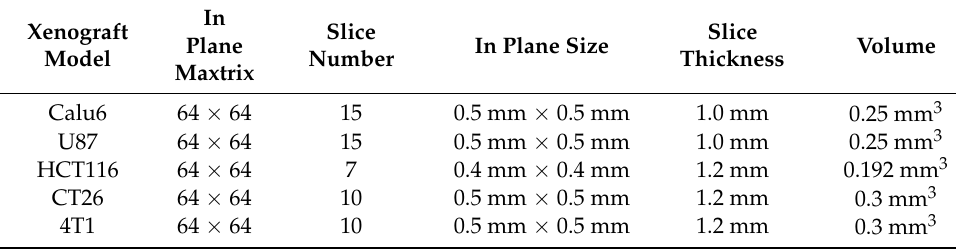
Table 1. Cell line specific MRI